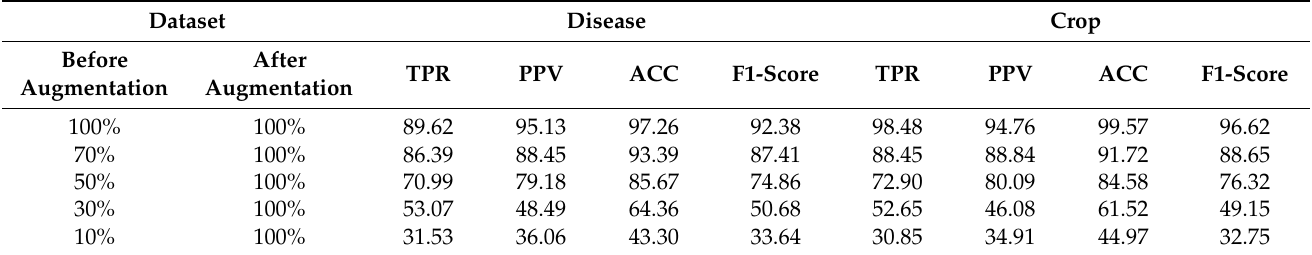
Table 22. Comparison of accuracies achieved by the proposed PI-CNN in the original and